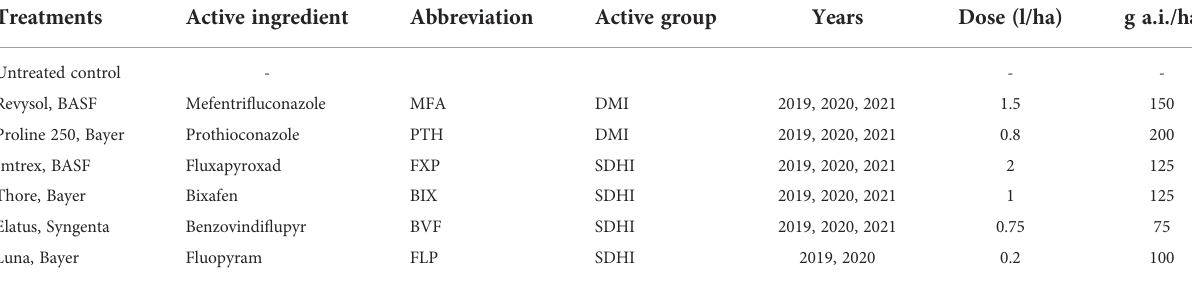
TABLE 1 Treatments used in all trials with full dose applications were carried out at growth stage GS 37-39.